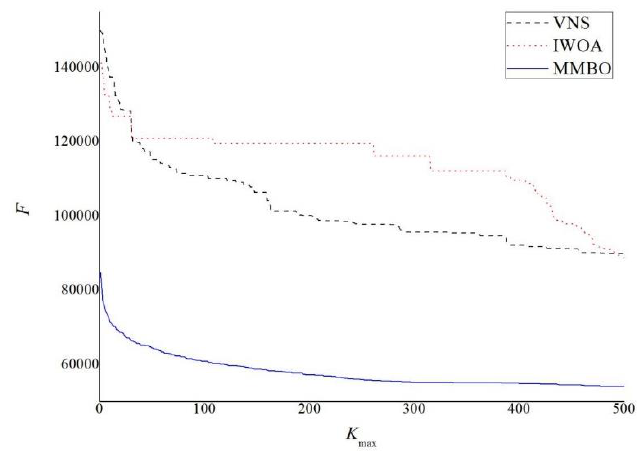
Figure 4. Convergence curve of the compared algorithms in Instance RM14.